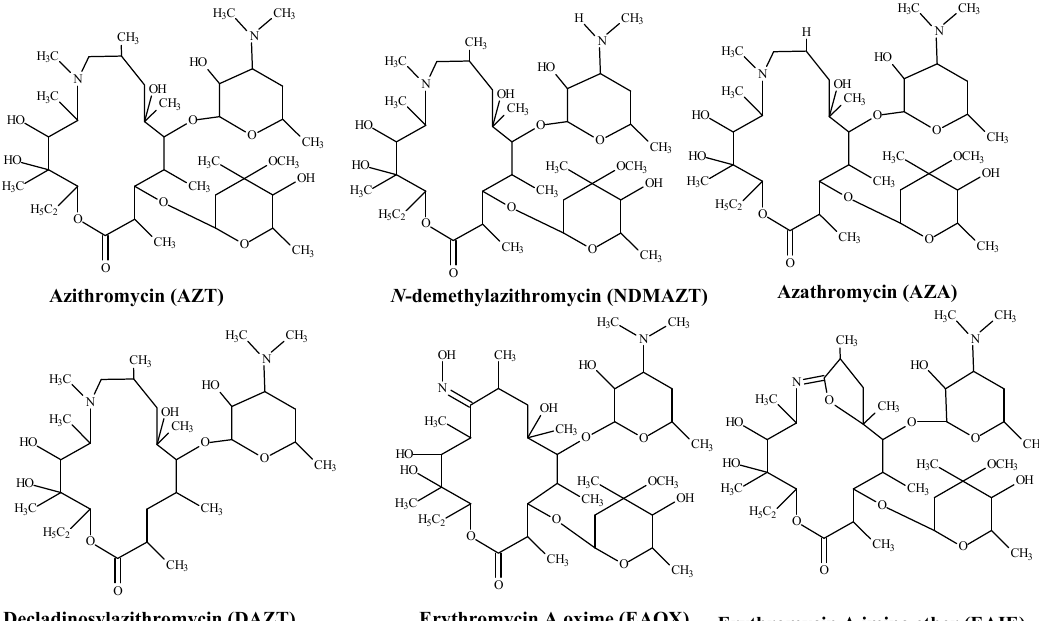
Figure 1. Chemical structures of azithromycin and some related substances.